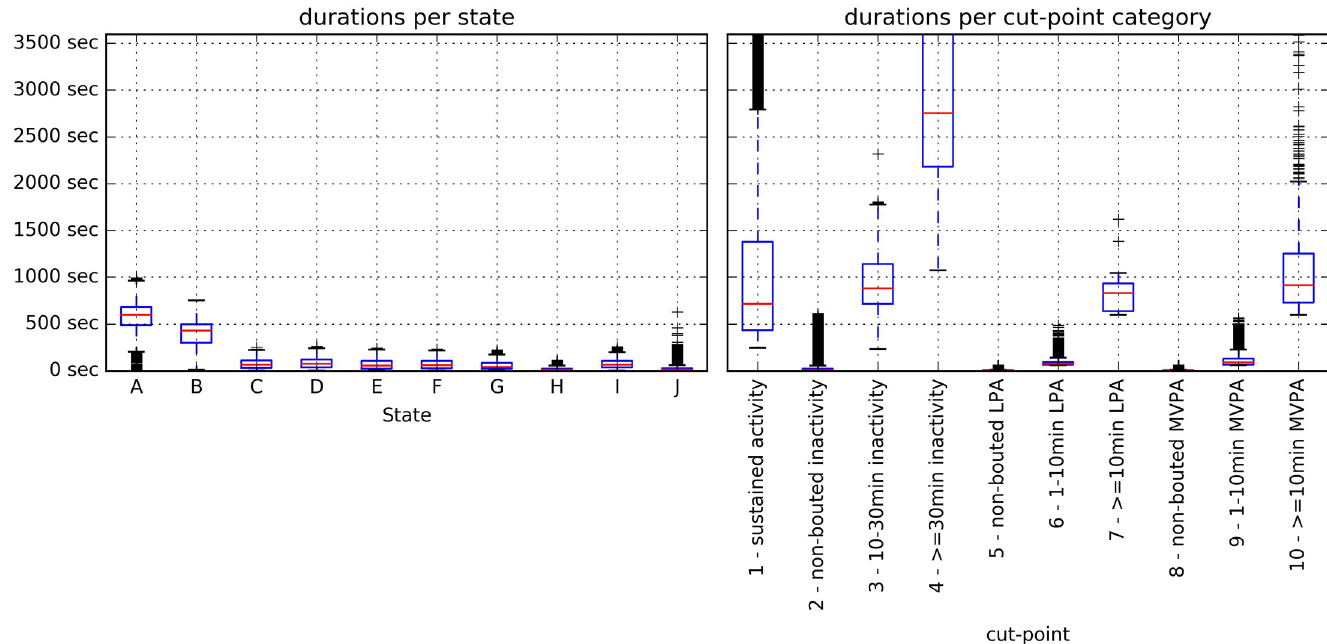
Fig 5. Durations for each HSMM state (acceleration+angles model) (left) and each cut-points category (right).